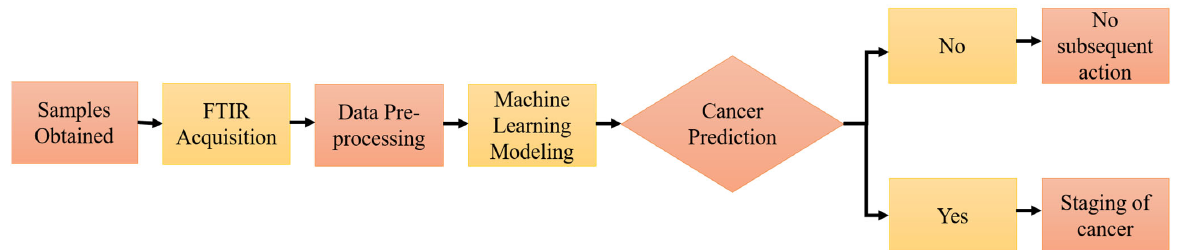
Figure 4. Supervised machine learning workflow. Reproduced with permission from ref. [155], Diagnostics ; published by MDPI, 2022.